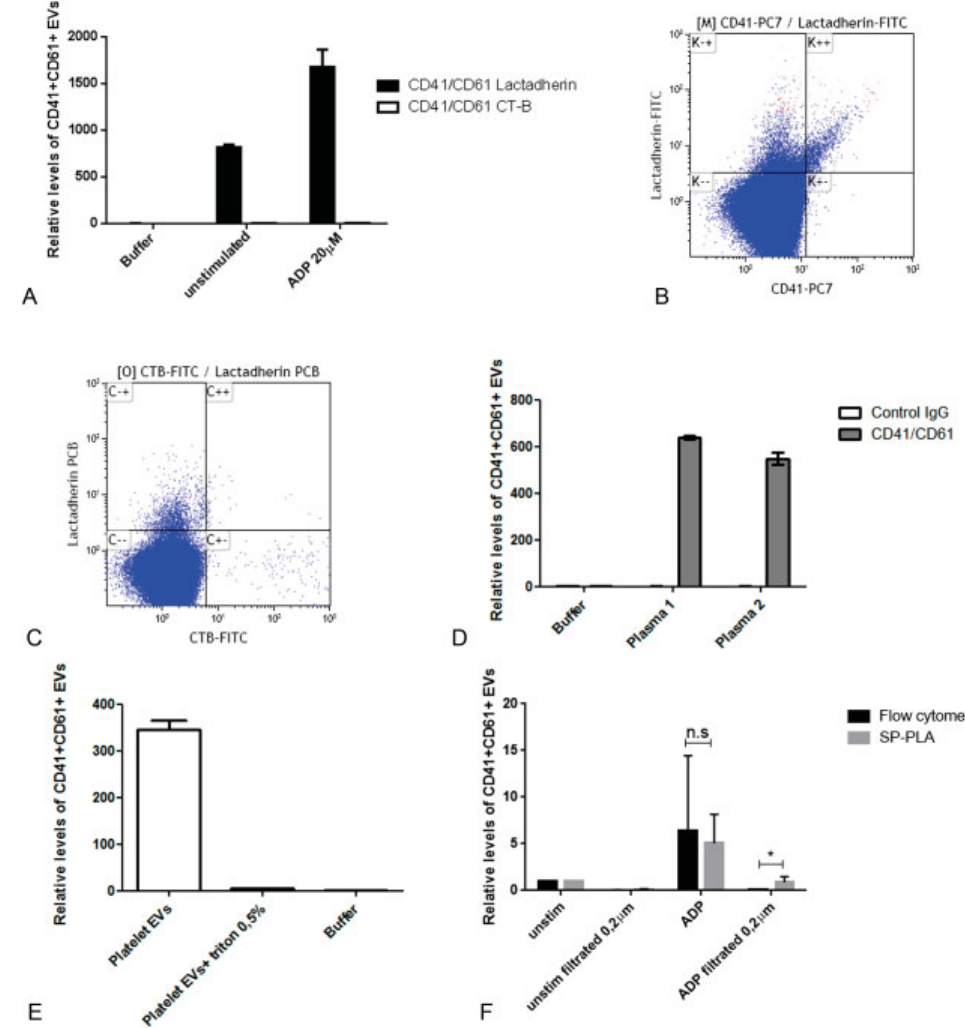
Fig. 2 Detection of platelet-derived EVs using SP-PLA. ( A ) Detection of CD41/CD61 þ EVs in plasma (diluted 1:100 in PLA buffer) using SP-PLA after lactadherin capture (black bars) and CT-B capture (white bars). Levels relative to the negative control with only PLA buffer (set to 1) are shown. Error bars represent standarddeviation ( n ¼ 2). ( B ) Plasmafrom ADP-stimulatedwholeblood was analyzed by fl ow cytometry usinga Navios from Beckman Coulter withthegateseton0.3 – 0.9 μ mparticlesde fi nedbypolystyrenebeads.Onerepresentative fl owcytometryanalysis(dotplot)oflactadherin-FITCandCD41- PC7 – positive events is shown. ( C ) Representative fl ow cytometry analysis (dot plot) of CT-B-FITC and lactadherin PCB. ( D ) Mouse control IgG or CD41 and CD61antibodieswereappliedinSP-PLAandsignalsfromEVsinplasma(diluted1:100)fromtwoindividualsareshownrelativetonegativecontrolwithonly PLA buffer (set to 1). Error bars represent standard deviation from replicates ( n ¼ 2). ( E ) Puri fi ed platelet EVs were lysed or not with 0.5% triton-X-100